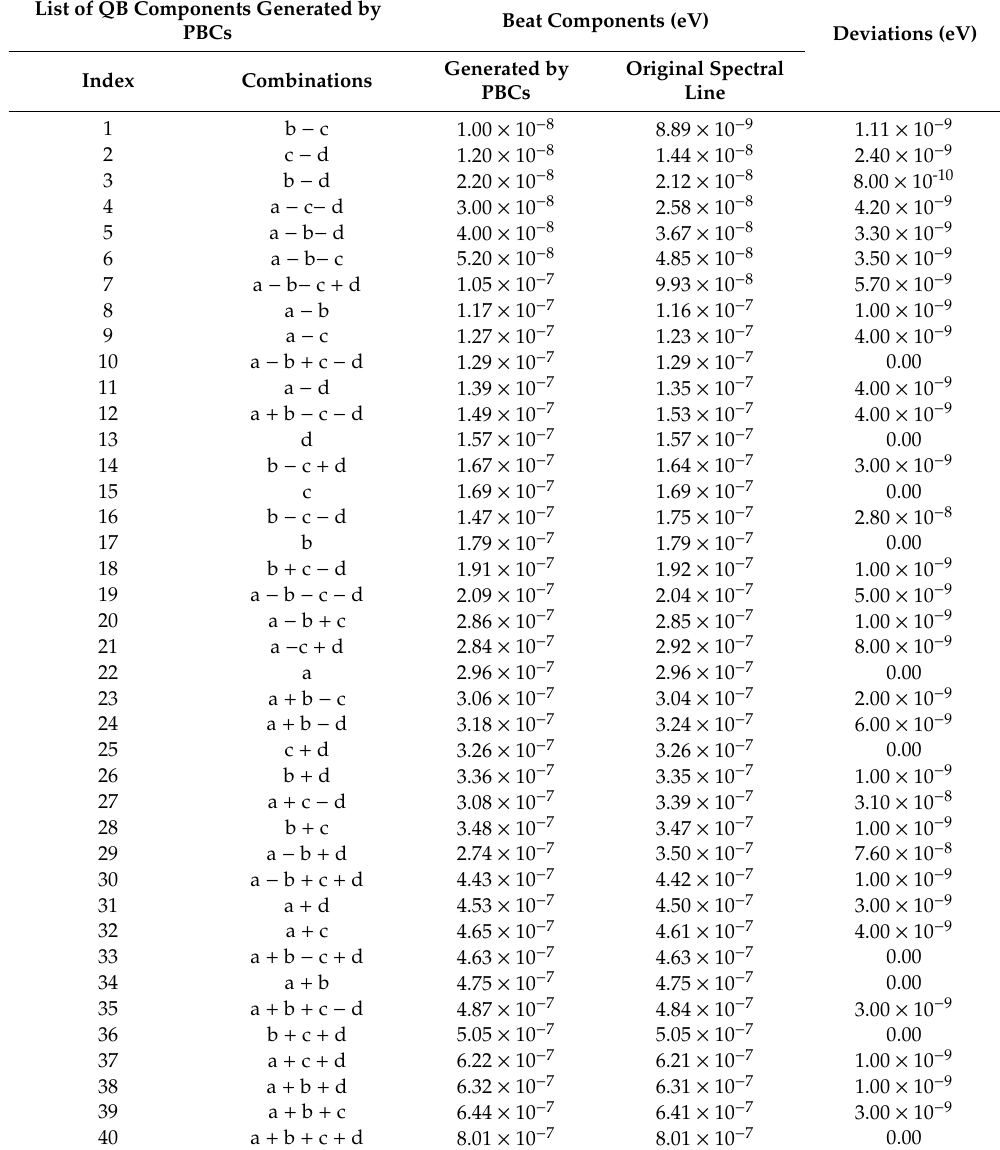
Table 1. Forty beat components generated by PBCs and contrast with the spectral lines from the QB